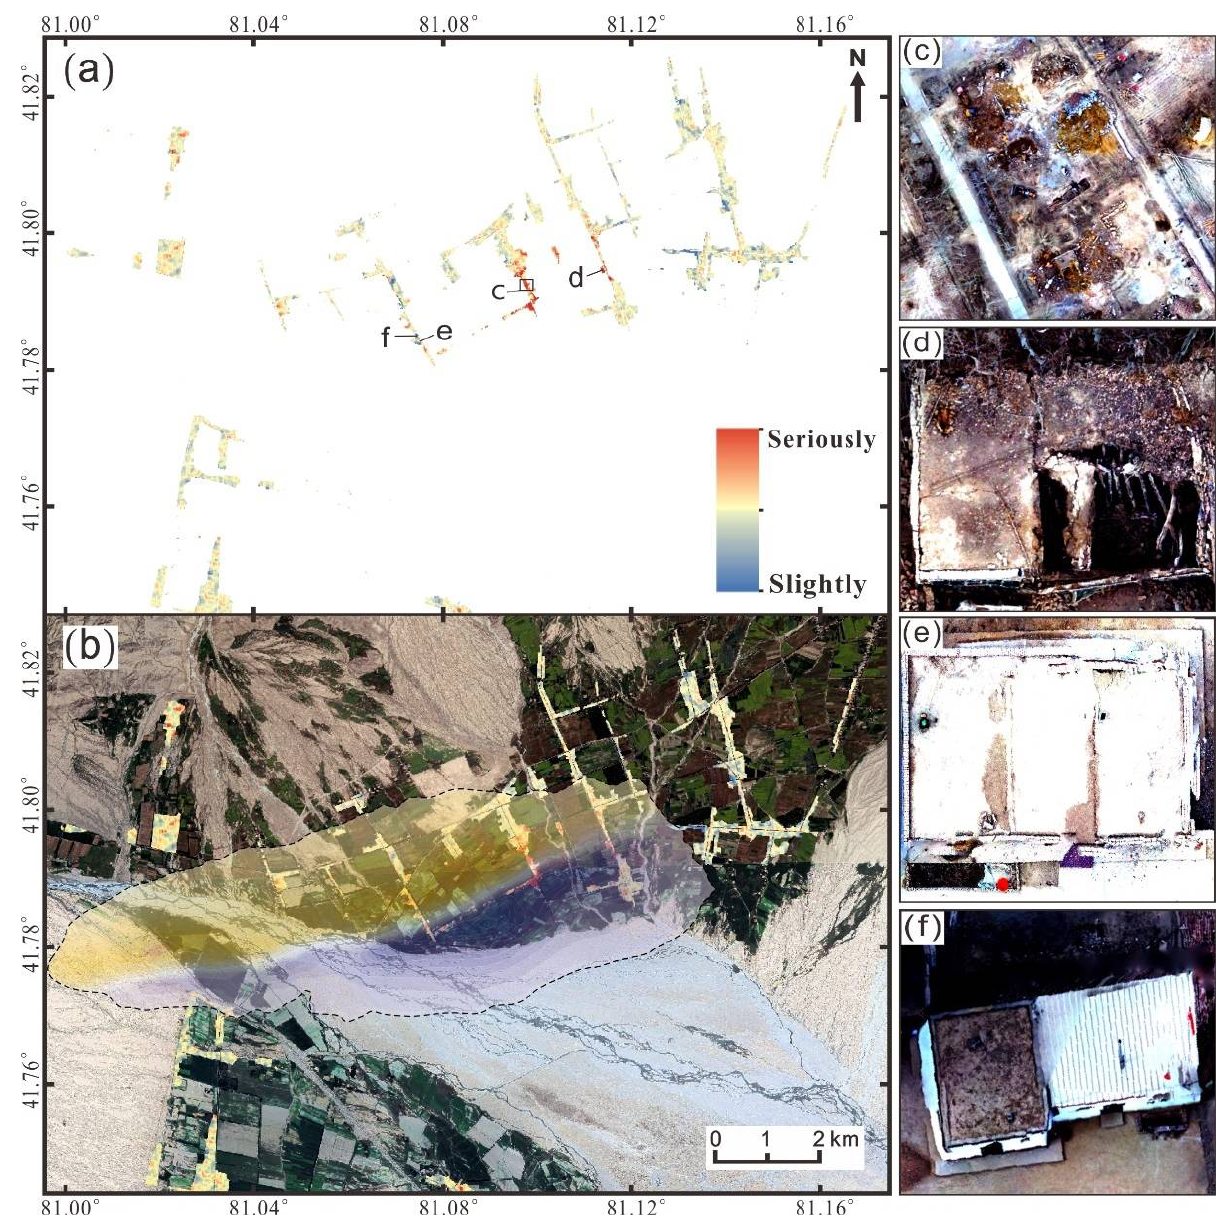
Figure 12. Building damage assessment map. ( a ) Building damage assessment map based on the